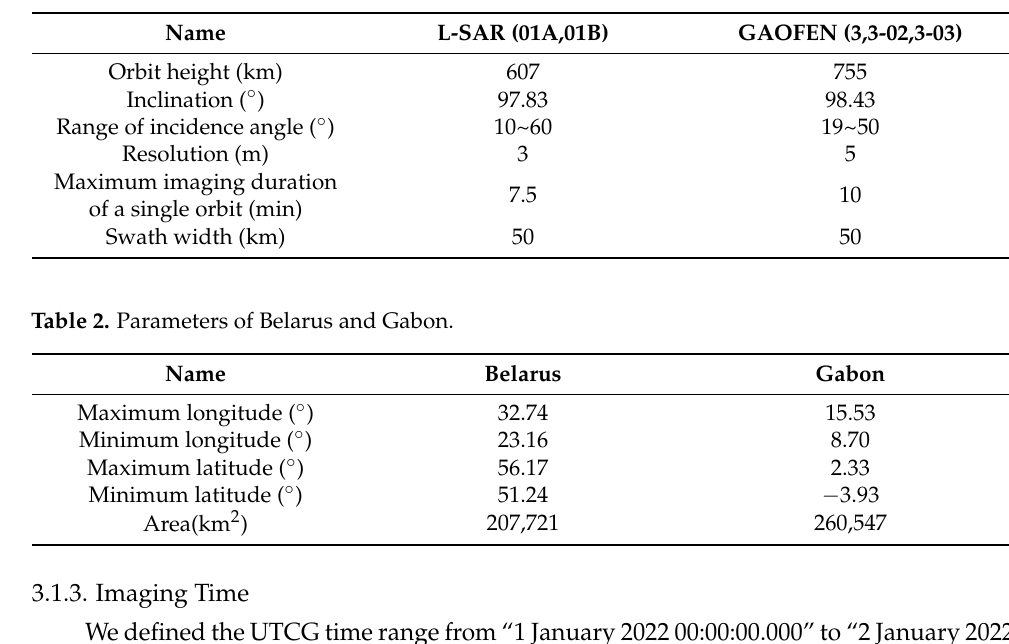
Table 1. Several parameters of the five selected SAR satellites and their sensors.